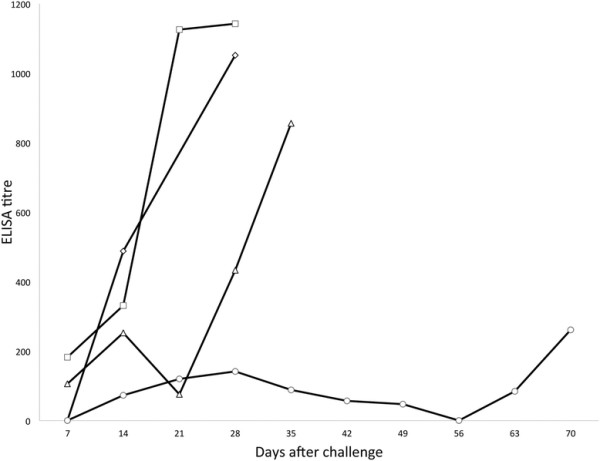
ELISA analysis of virus-specific antibodies in the four animals from group 3 that succumbed to MCF after challenge. Relative titres of antibodies in the nasal secretions of each animal at a range of timepoints after challenge are plotted individually. Each animal is represented by a different symbol, joined by solid lines. The rightmost point in each line corresponds to the sample collected on the day of post mortem.